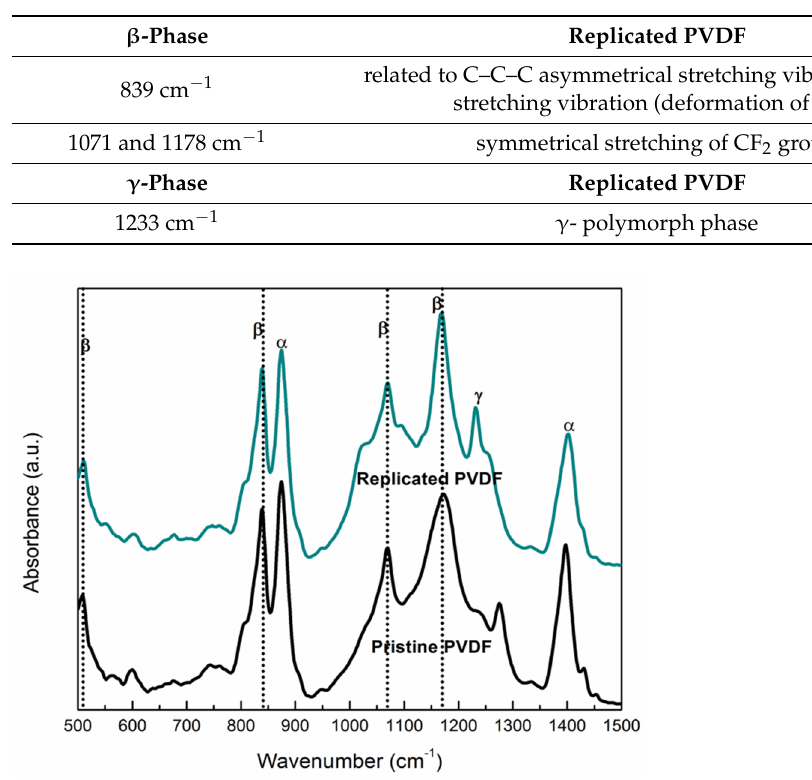
Table 1. Summary of Replica PVDF β , γ - phases.